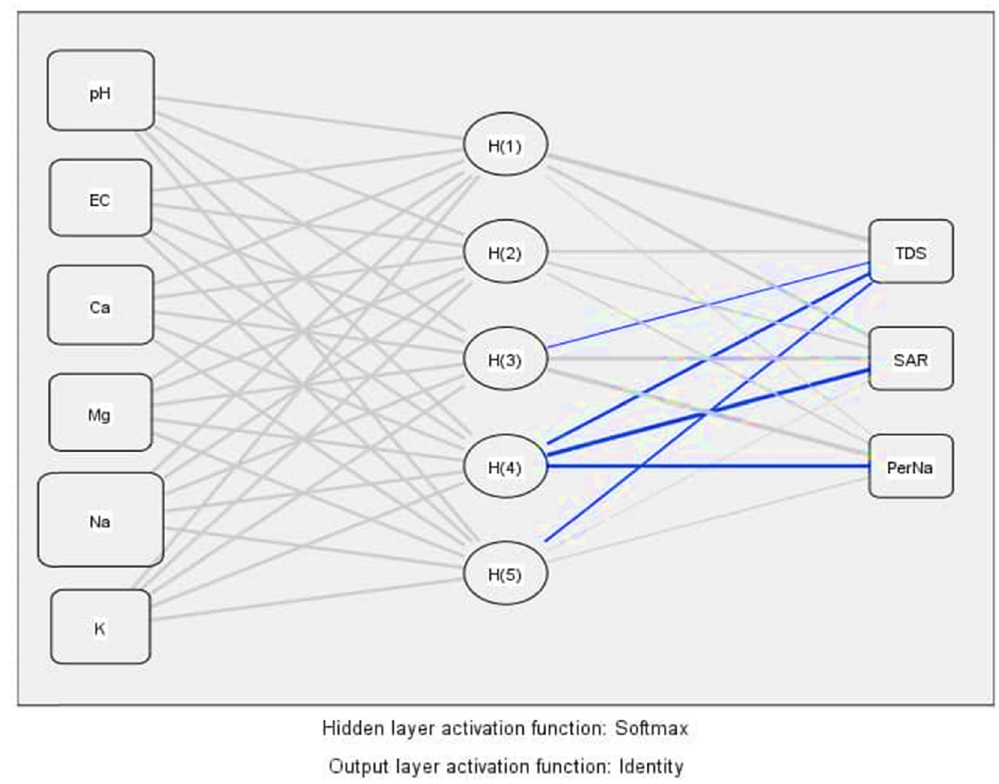
Figure 4: The proposed ANN.